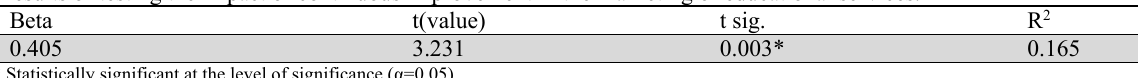
Results of testing the impact of continuous improvement in the marketing of educational services.